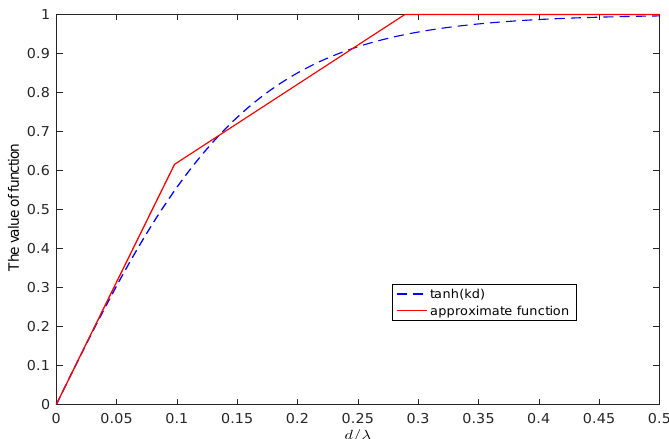
Figure 1. The relationship between the function tanh ( kd ) and the approximate